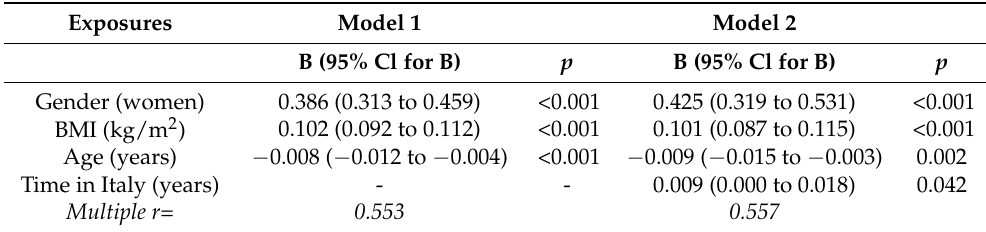
Table 3. Determinants of discrepancy score (categories) in the Chinese migrant cohort at multivariate linear